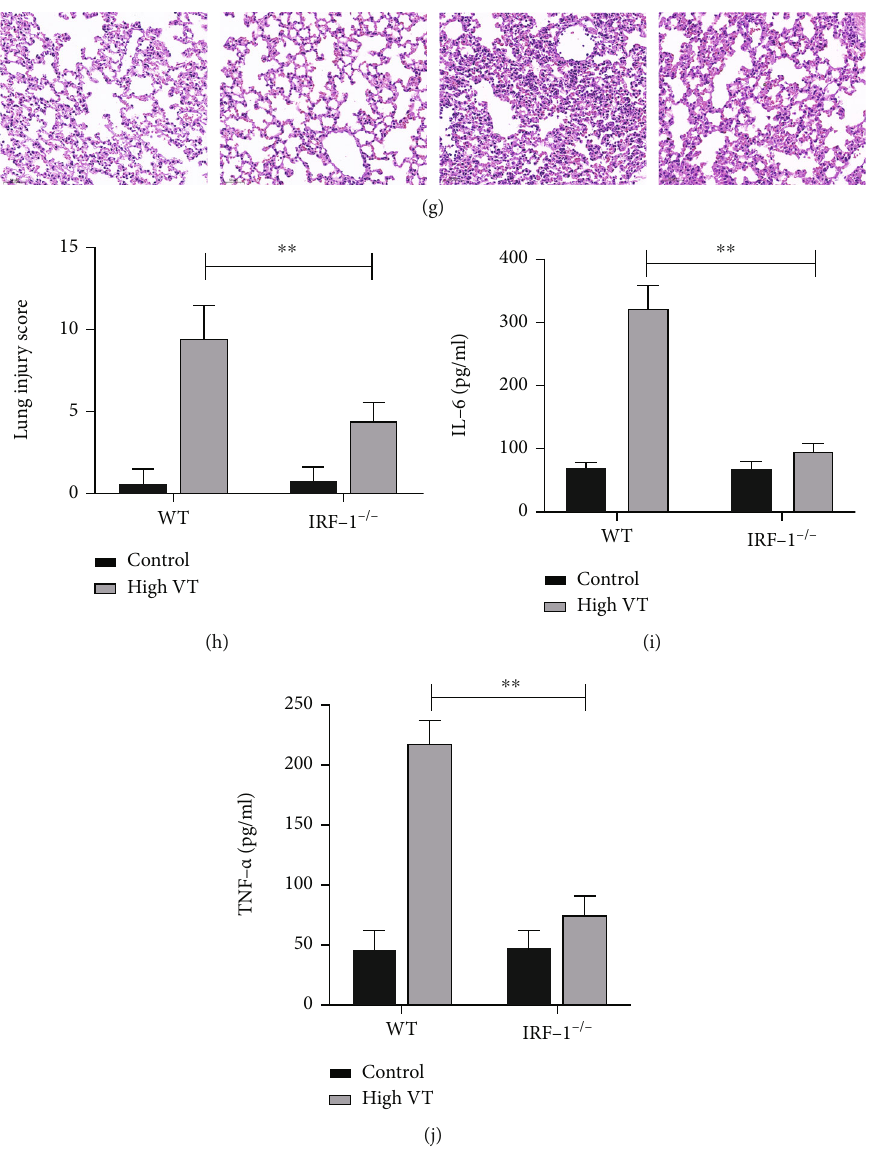
Figure 4: IRF-1 deletion attenuates VILI and cytokine release in mice. The intranuclear protein level (a) and mRNA (b) of IRF-1 in alveolar macrophages were increased in the high VT group compared with the control group and the low VT group. IRF-1 deletion alleviated lung histopathologic damage in gross pathology (e), HE-stained micrographs for 20 × magni fi cation (f) and 400 × magni fi cation (g) induced by the high-tidal-volume ventilation assessed using lung injury scores (h). IRF-1 deletion alleviated the wet/dry (W/D) ratio (c) and BALF protein concentration (d) in the high VT group. The concentration of IL-6 (i) and TNF- α (j) in BALF was attenuated after high VT with IRF-1 deletion compared to that wild type. Results are representative of three independent experiments; the results of one representative experiment are shown ( n = 5 /group, ∗ p < 0 : 05 , ∗∗ p < 0 : 01